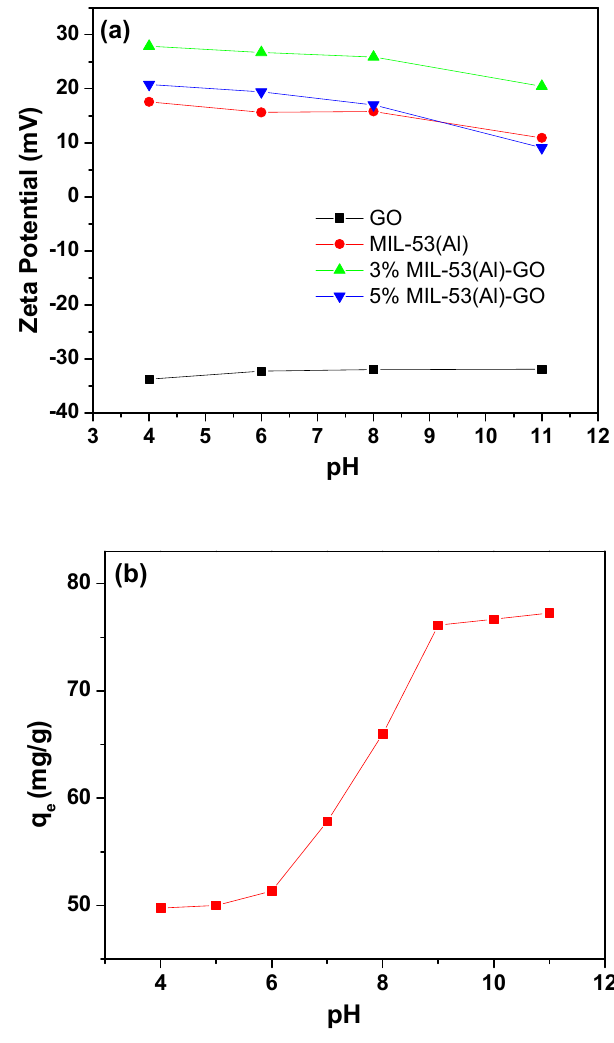
Figure 4. ( a ) Zeta potential of GO, MIL-53(Al) and MIL-53(Al)-GO nanocomposites and ( b ) effect of pH on As(III) adsorption onto 3% MIL-53(Al)-GO ( C 0 = 50 mg/L, M / V = 0.4 g/L, and T = 298 K).